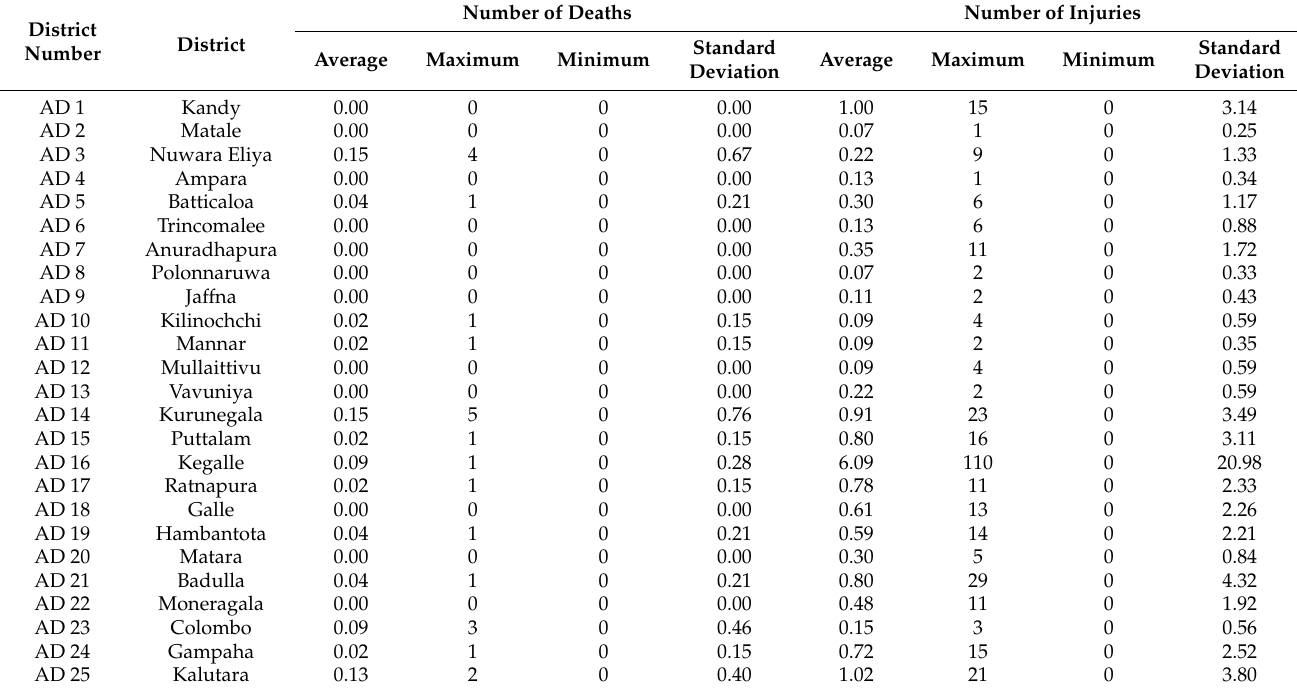
Table A2. Statistical variations of the property damage in each administrative district of Sri Lanka due to lightning, from 1974 to